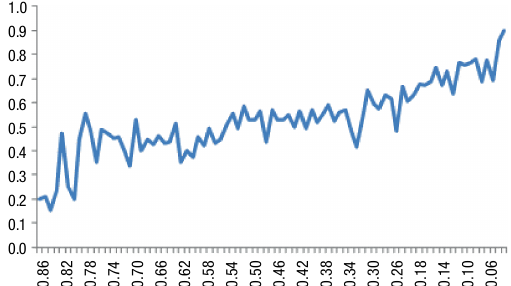
Fig. A.1. Relationship between the probability of increasing the equity exposure ( p ( t ) values) and the previous equity weight ( β